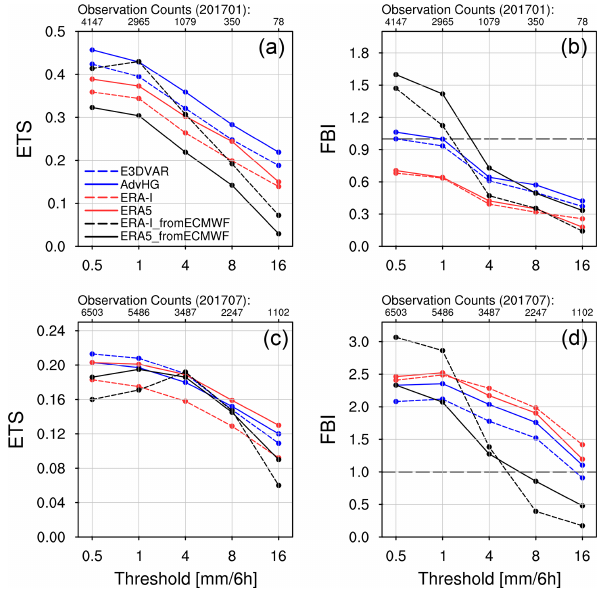
Figure 8. (a, c) ETS and (b, d) FBI for (a, b) January and (c, d) July 2017 depending on thresholds 0.5, 1, 4, 8, and 16mm per 6h. ECMWF (i.e., ERA-I_fromECMWF,